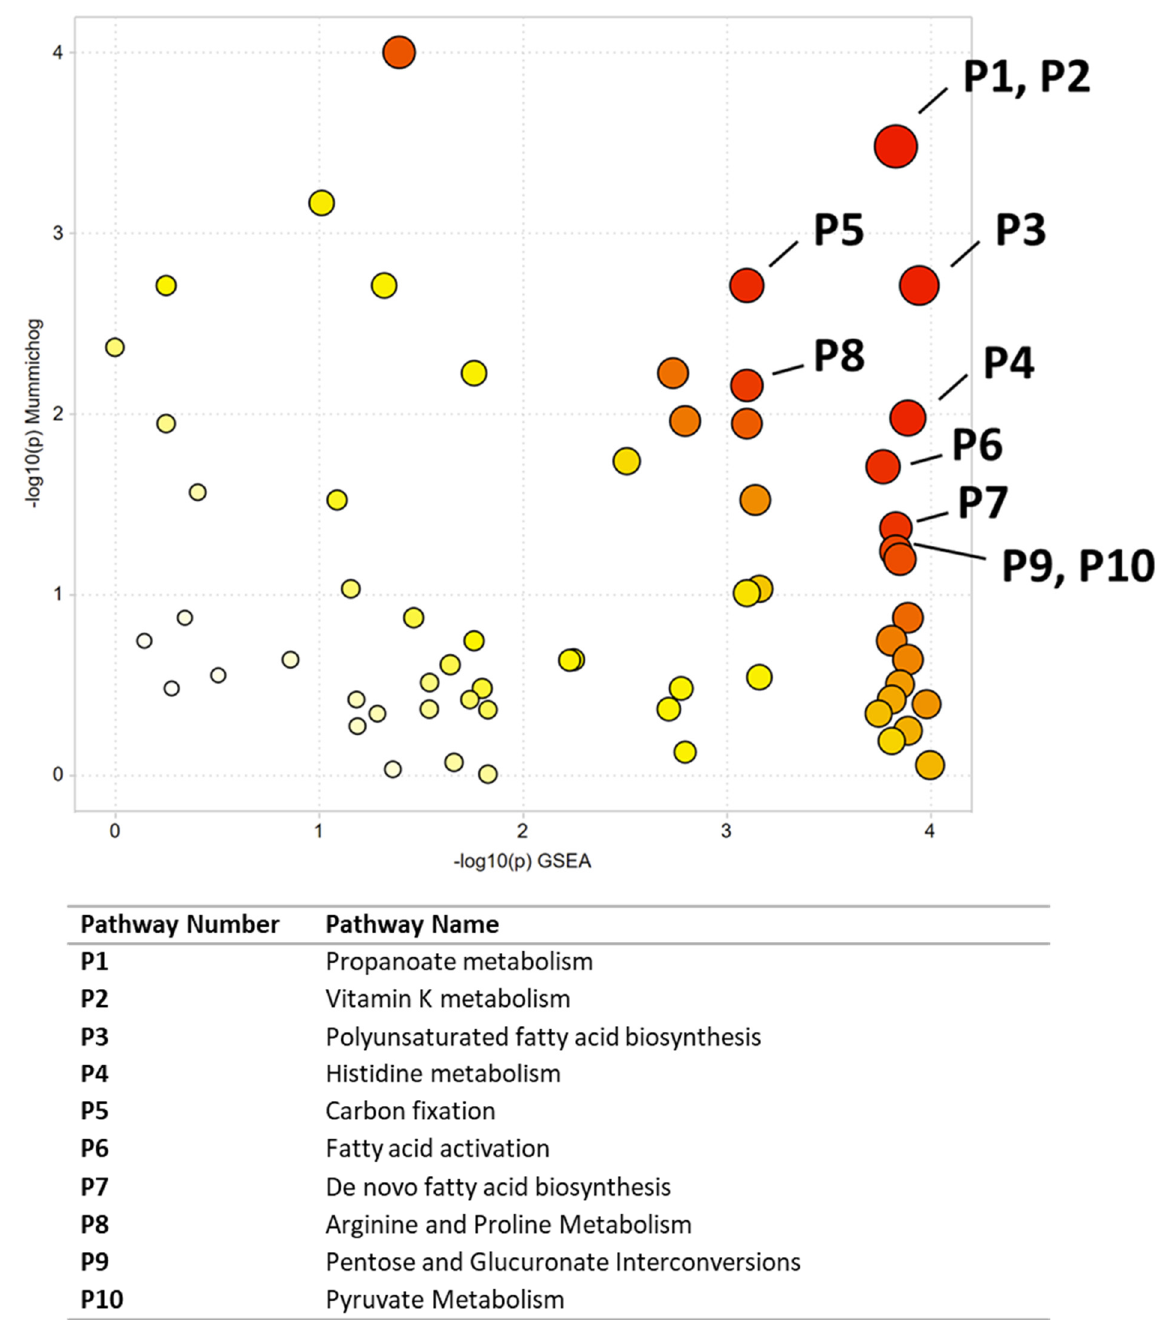
Figure 5. Pathway enrichment using Metaboanalyst to compare malignant and normal oral tissues. All significant pathways are listed in Table 5. Darker circles represent pathways with a lower p -value. Larger circles indicate a higher number of significant metabolite hits relative to the total pathway size. Table 5. Significantly perturbed metabolic pathways that differentiated malignant and oral tissues.